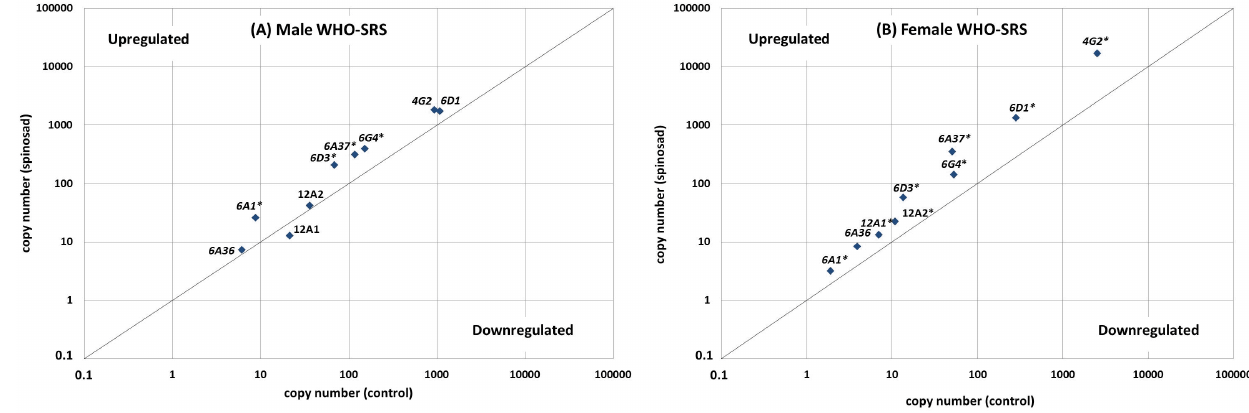
Figure 1. WHO-SRS male (A) and female (B) spinosad-influenced gene expression as a function of the constitutive gene expression. The line represents no effect of spinosad exposure. Genes in right-lower and left-upper corner are down-regulated and up-regulated by spinosad, respectively. Points marked with * are significantly different from the separation line by a =0.05.